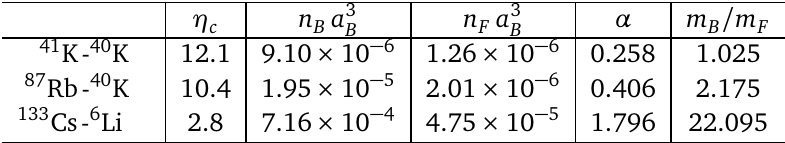
Table 1: The second column: Values of the critical ratio | a fourth column show the corresponding bosonic and fermionic densities. The fourth and fifth one give the values of the α parameter and the mass